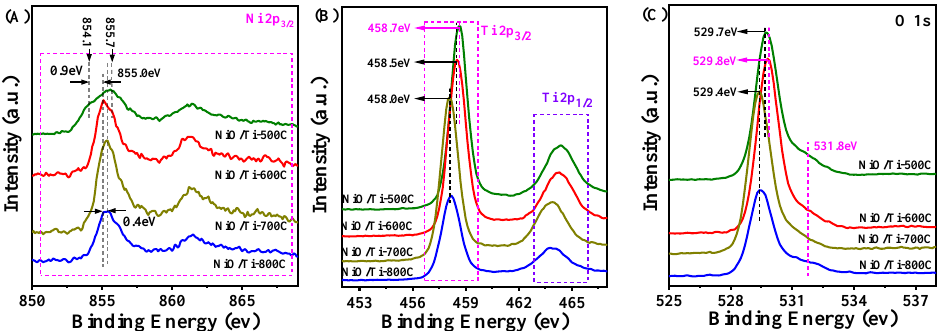
Figure 4. XPS spectra of Ni 2p ( A ), Ti 2p ( B ) and O 1s ( C ) for the above samples. Combined with XRD, UV-vis DRS, H 2 -TPR and BET characterization results, increas- ing the calcination temperature, the interaction force and the electronic effect between NiTiO 3 and the support TiO 2 is also enhanced. For NiO/Ti-600C catalyst, the active